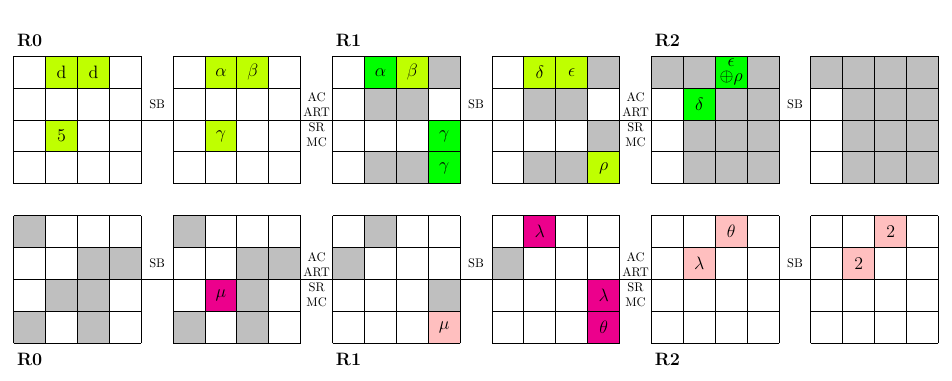
Figure 4: Toy example of boomerang cluster on 3 rounds of SKINNY-64 in the SK model